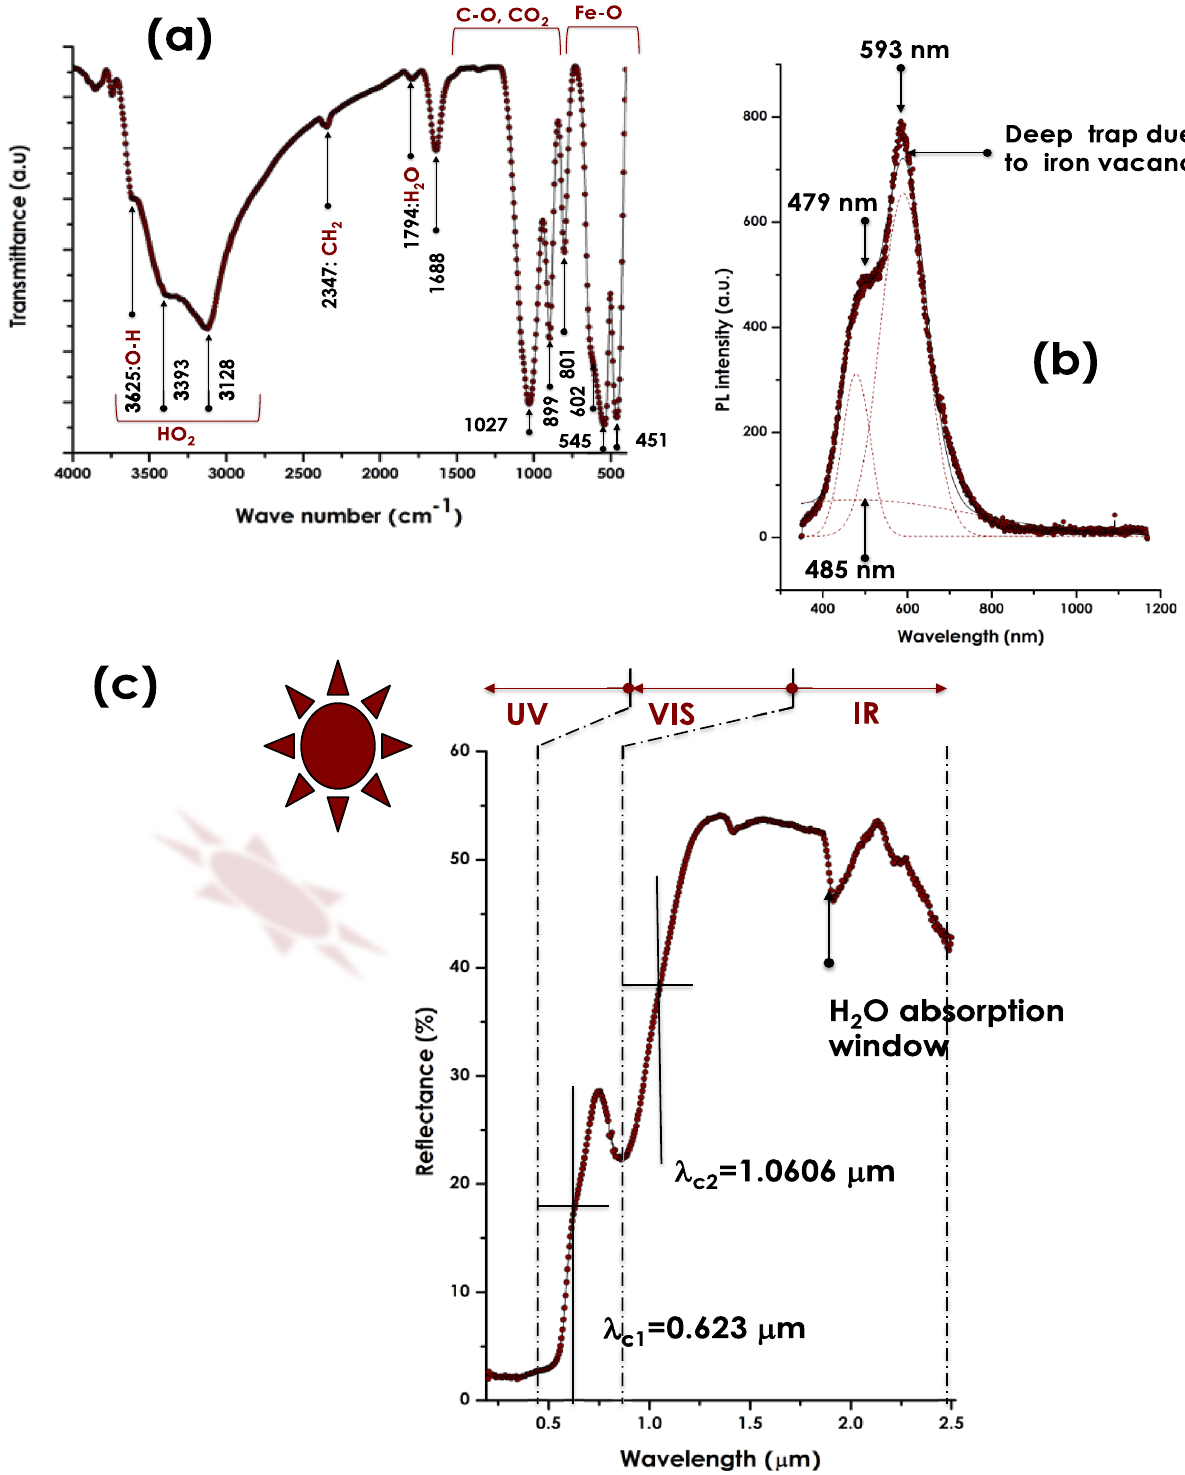
Figure 4. ( a ) ATR-FTIR vibrational modes of the Red Ochre pigment, ( b ) its Photoluminescence emission spectrum under an excitation wavelength λ exc = 270 nm, and ( c ) its UV–VIS-NIR reflectance in the spectral range of 190–2500